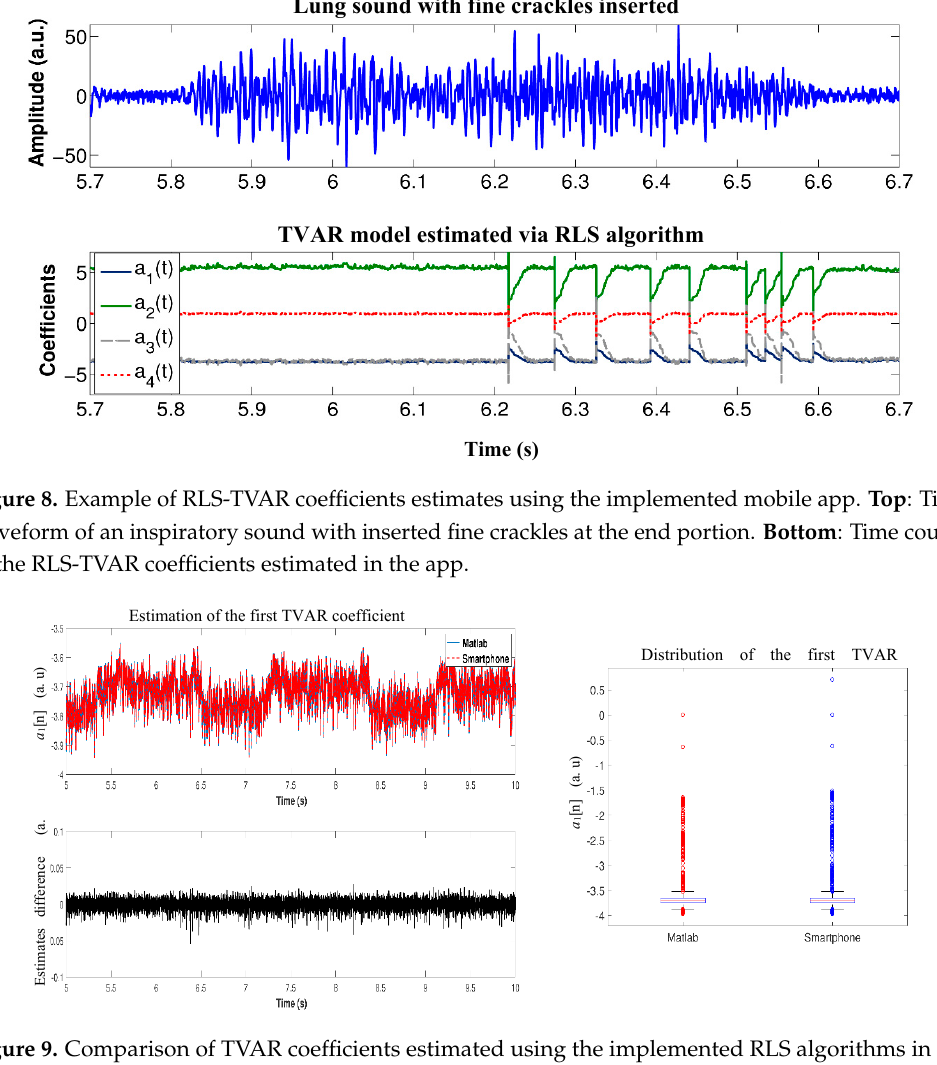
Figure 9. Comparison of TVAR coefficients estimated using the implemented RLS algorithms in the mobile app and Matlab. Left : Example of estimates and difference between the estimates in both systems. Right : Distribution of the TVAR coefficient estimated in both systems.